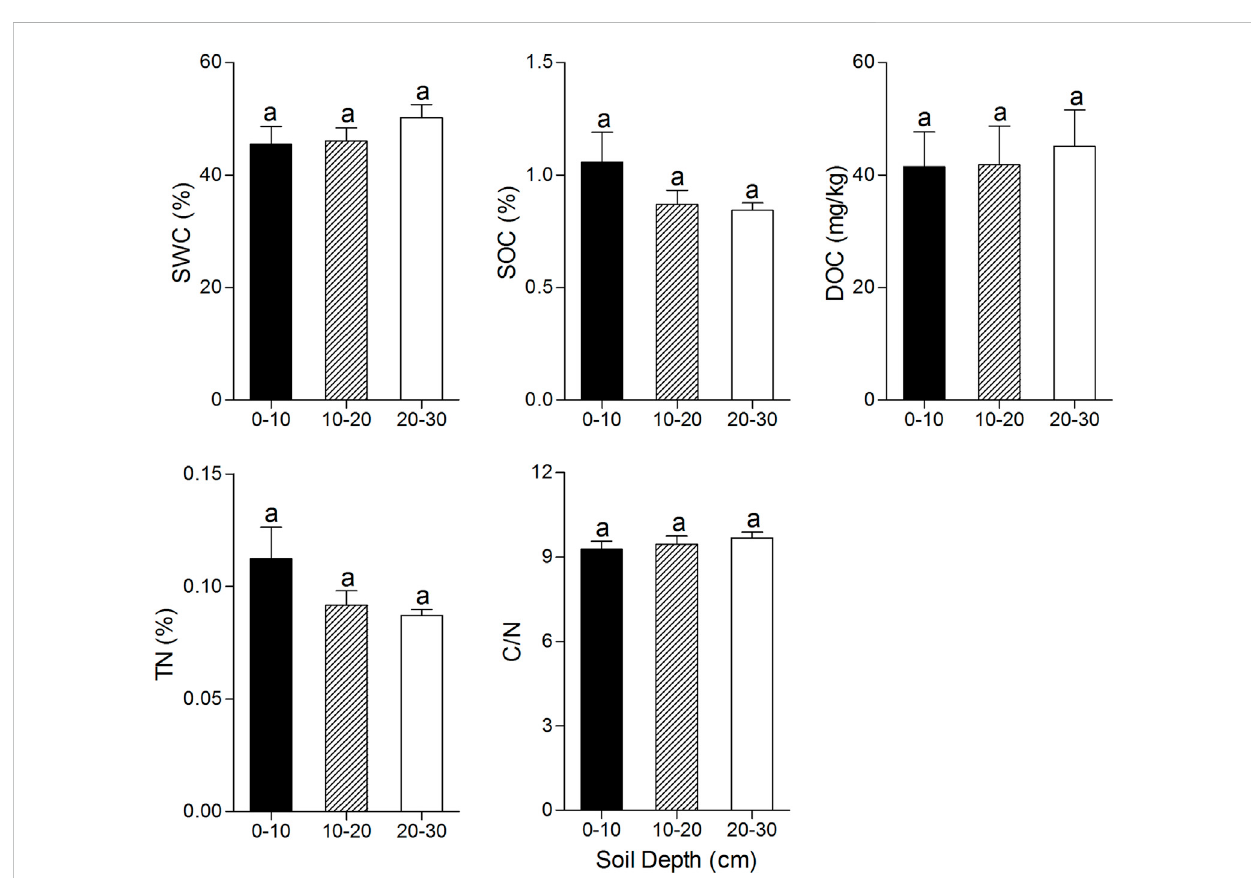
FIGURE 2 Soil properties (mean ± SE) at 3 layers of soil depth. The values of each soil property with the same lowercase letter do not differ signi fi cantly ( p > 0.05) based on Dunn ’ s multiple comparison